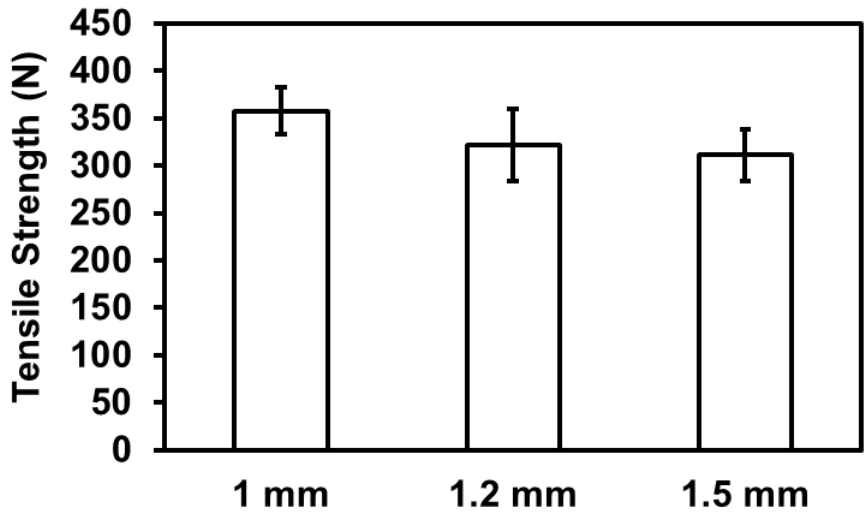
Figure 8. Tensile strength of Kevlar/TPU laminated composites as related to the thickness.